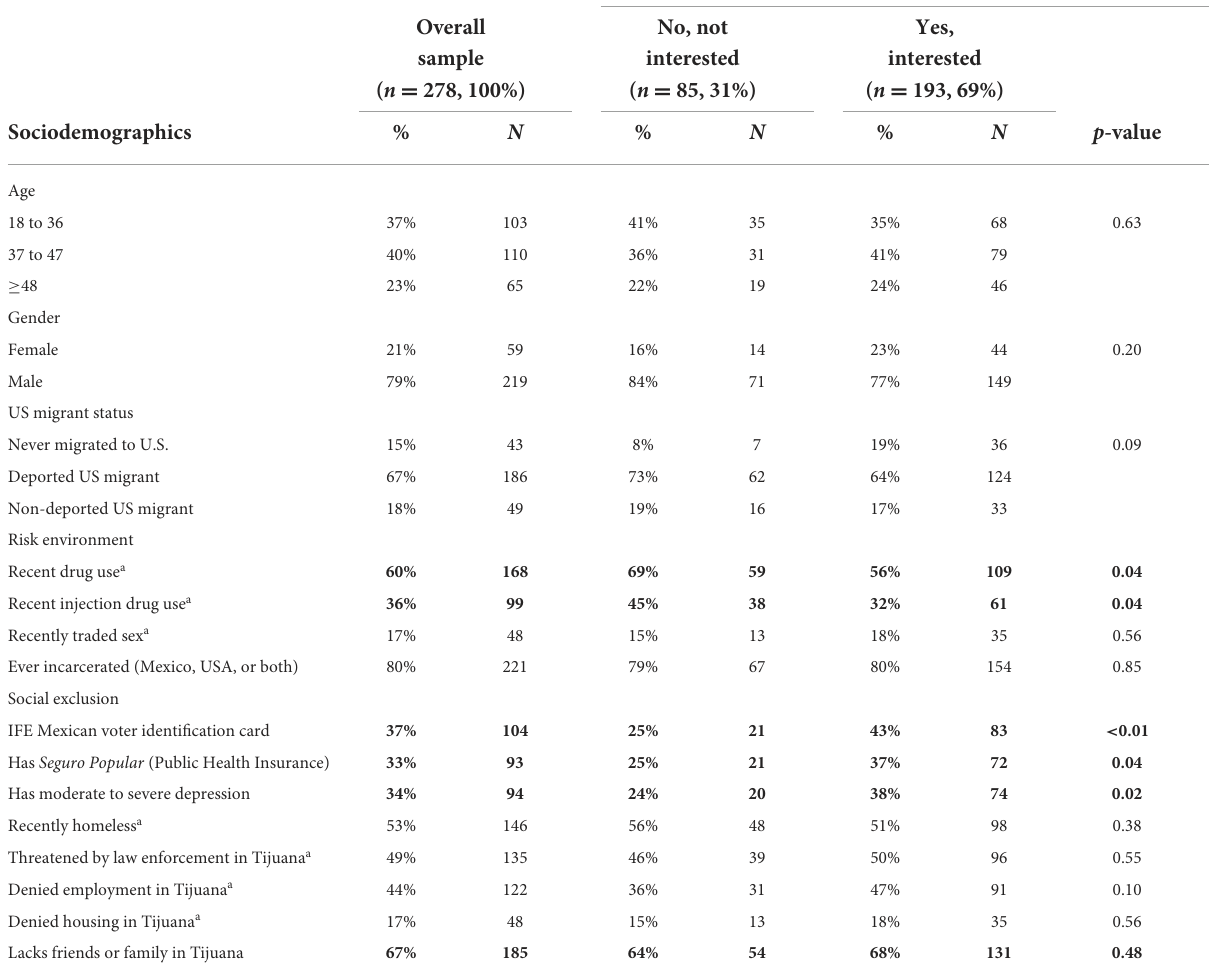
TABLE 1 Sociodemographic characteristics of Mexican tattooed adults ( n = 278) receiving free medical care, stratified by interest in receiving free laser tattoo removal at the study site, Tijuana, Mexico,